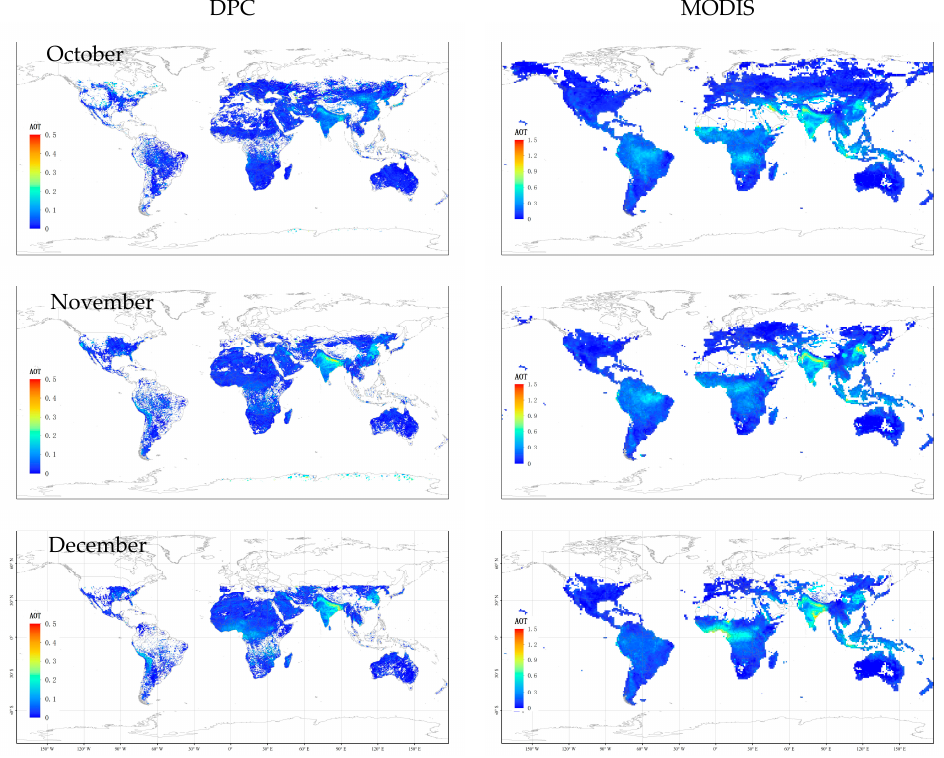
Figure 1. The global monthly average AOD from October to December in 2018 derived from DPC and